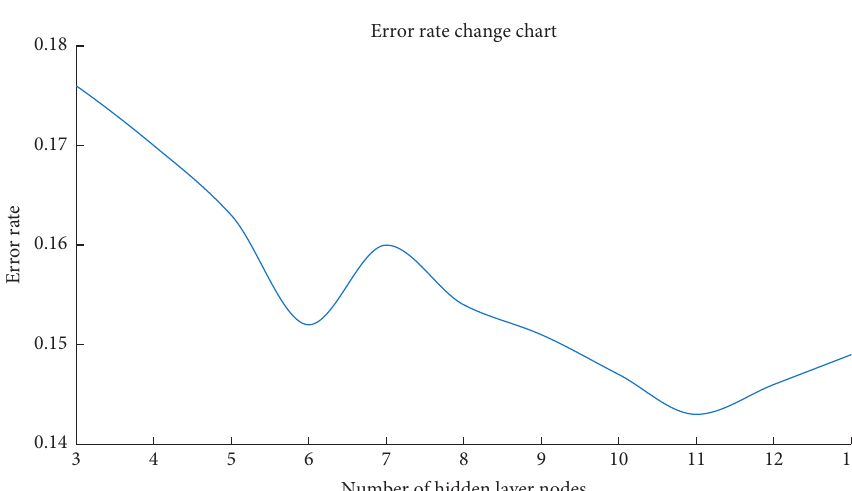
Figure 2: Relationship between the number of neurons in the hidden layer and error rate.